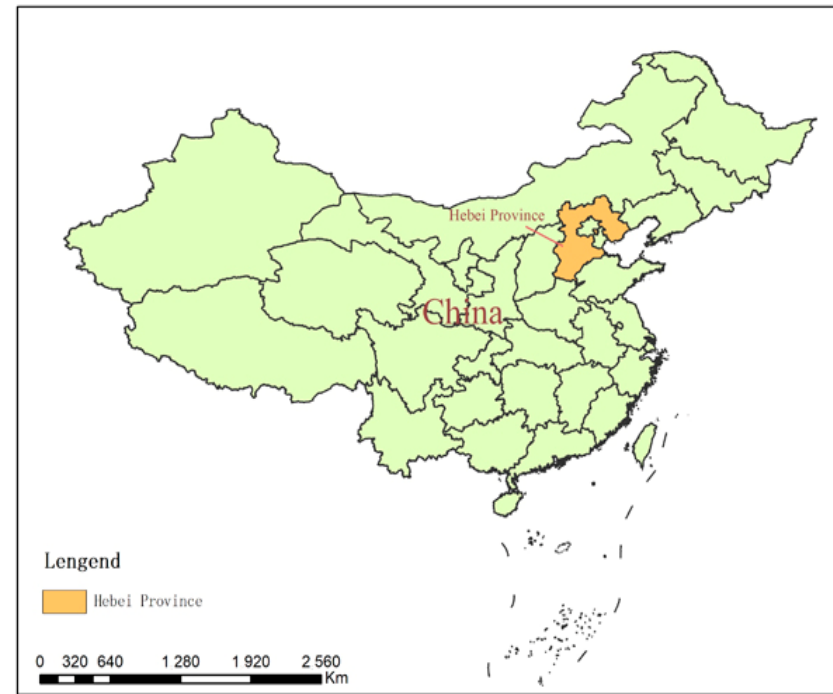
Figure 3. Location of the study area.